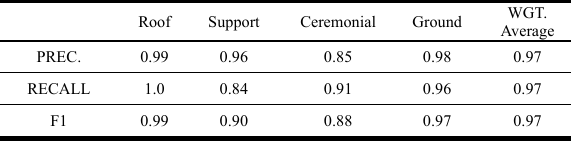
Table 3. Classification metrics at level 1 for FKS.